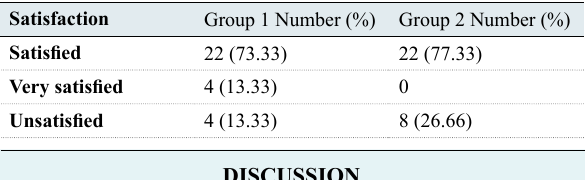
Table 3: Satisfaction of level of the study population